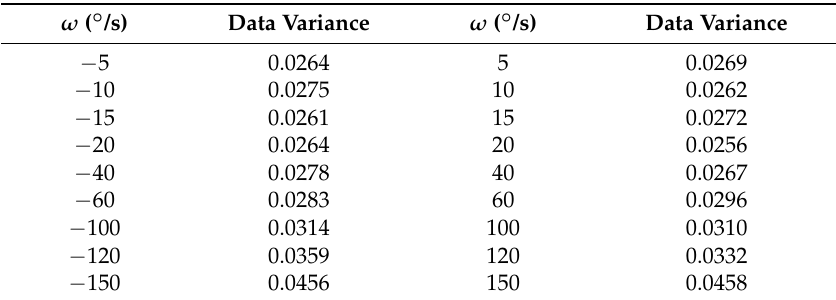
Table 1. Different angular rate gyroscope output data.